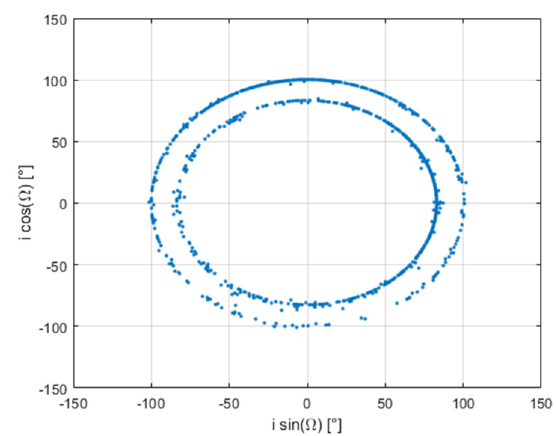
Figure 7. Distribution of reference fragments in plane i sin( Ω )- i cos( Ω ) for first test case.